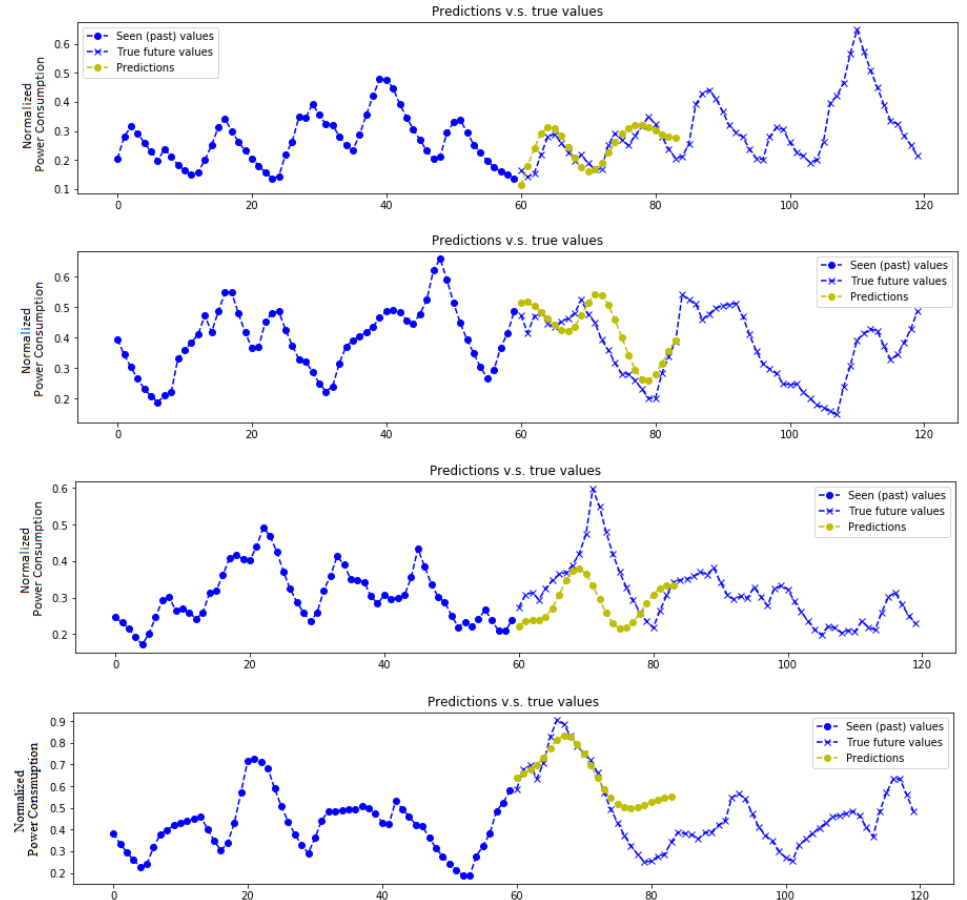
Figure 9. The future versus predicted energy consumption through time. The dot points refer to the past values, the X-points refer to the future values, and the green dots refer to the prediction